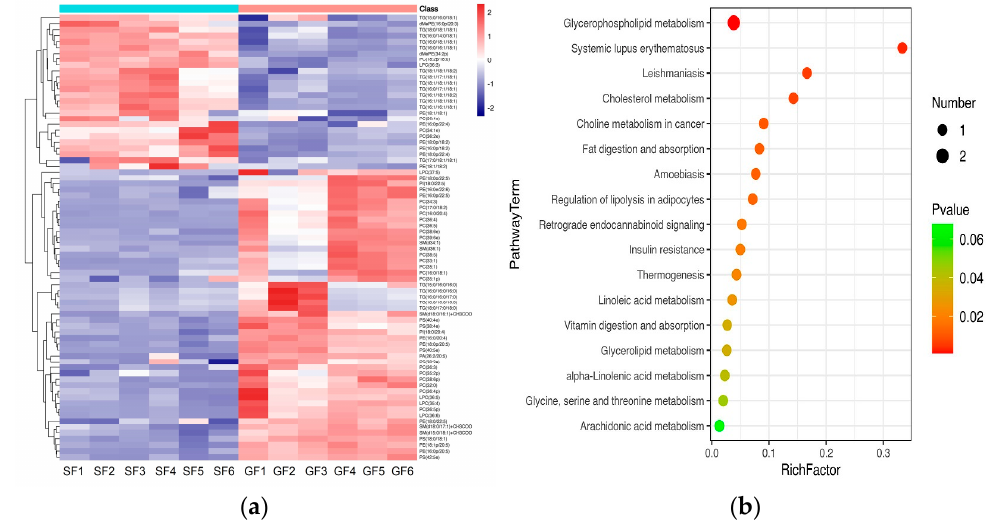
Figure 2. ( a ) The heatmap of SDLs in the yak’s LD under SF and GF. In the color scale, red and blue indicate the increase and decrease of SDL’s concentration, respectively. ( b ) Bubble chart of Kyoto Encyclopedia of Genes and Genomes (KEGG) enrichment analysis for SDLs in yak’s LD under SF and GF. The horizontal axis and the vertical axis represent the rich factor and the pathway term, respectively. Rich Factor is the ratio of the number of SDLs annotated in a certain KEGG pathway item with the number of all lipids annotated in this KEGG pathway item. The size and color of the bubble represent the number of DEG enriched in the KEGG pathway and the different p -value range, respectively.